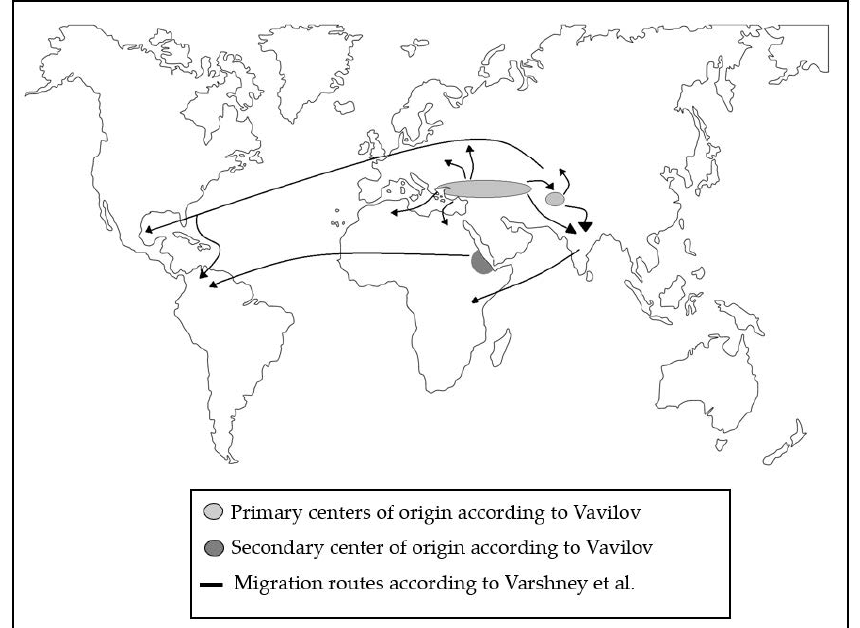
Figure 1. Zones of origin of cultivated chickpea ( C. arietinum ) and subsequent distribution around the world. Adapted from Croser et al. [20]. Currently, wild annual Cicer species are grouped into three gene pools (primary, sec- ondary, and tertiary) based on the studies considering the crossability and fertility of hy- brids in interspecific crosses with cultivated chickpeas, reflecting their genetic distance from the cultivated species [20]. The unsynchronized growth of the stigma and anthers is one of the main interspecific hybridization barriers. Limited compatibility leads to im- paired meiosis and imbalanced gamete formation and, therefore, the production of infer- tile hybrids [15,19]. The primary gene pool includes the cultivated chickpea C. arietinum and its immediate progenitor species, C. reticulatum , which is readily crossable with C. arietinum; their progeny is fully fertile due to good chromosomal pairing [15]. Therefore, it serves as a potential source to broaden the genetic base and enhance the yield compo- nents and stress tolerance traits in the cultivated gene pool [21 – 23]. The secondary gene pool comprises C. echinospermum, which is crossable with the cultivated species, but with reduced fertility of the resulting hybrids and subsequent progenies. Consequently, these species are potential donors of valuable alleles/genes for chickpea improvement. The ter- tiary gene pool consists of the remaining Cicer species, including annual species such as C. bijugum , C. judaicum , C. pinnatifidum , and C. cuneatum . These species cannot be easily crossed with cultivated chickpeas through conventional breeding methods [24]. The phy- logenetic relationship between the annual Cicer species belonging to the three different gene pools is shown in Figure 2, which was extracted from a recent study based on inter- nal transcribed spacer (ITS) sequences in Cicer taxa [15].